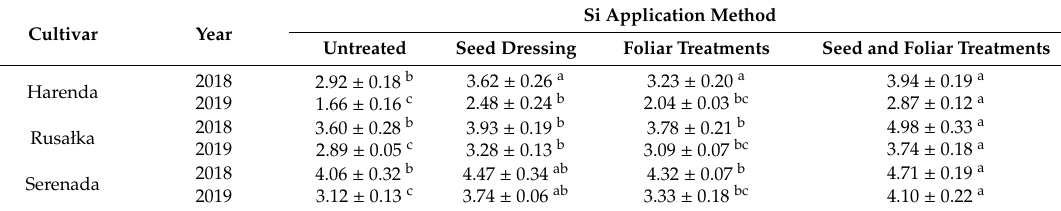
Table 5. Yield (t) in relation to method of Si application and wheat cultivar.